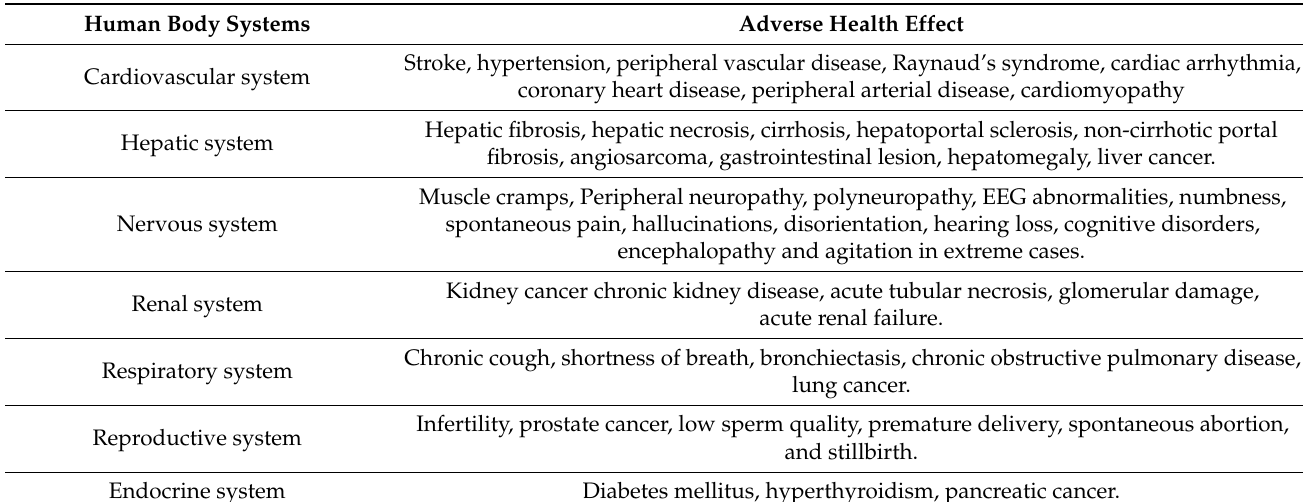
Table 11. Adverse health effects as a result of exposure to arsenic